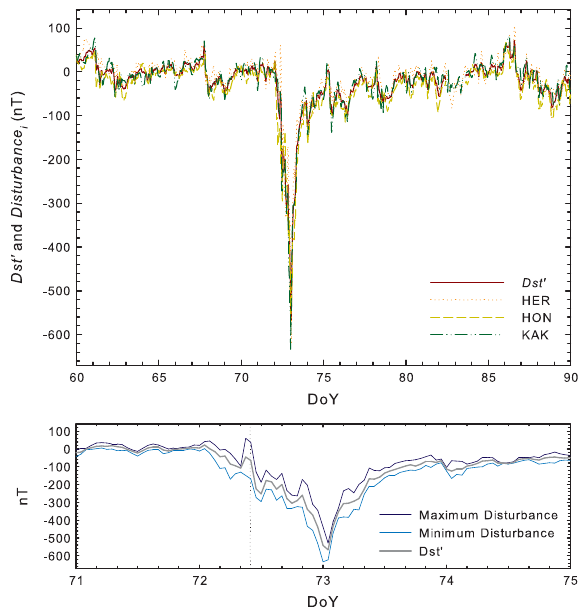
Fig. 2. Top: Dst 0 index and local disturbance recorded at the observatories of Hermanus, Kakioka, Honolulu for the 13 March 1989 storm. There are no data from San Juan magnetometer. Bottom: Dst 0 index (grey) and the local time maximum (dark blue) and minimum (light blue) value of the Disturbance i